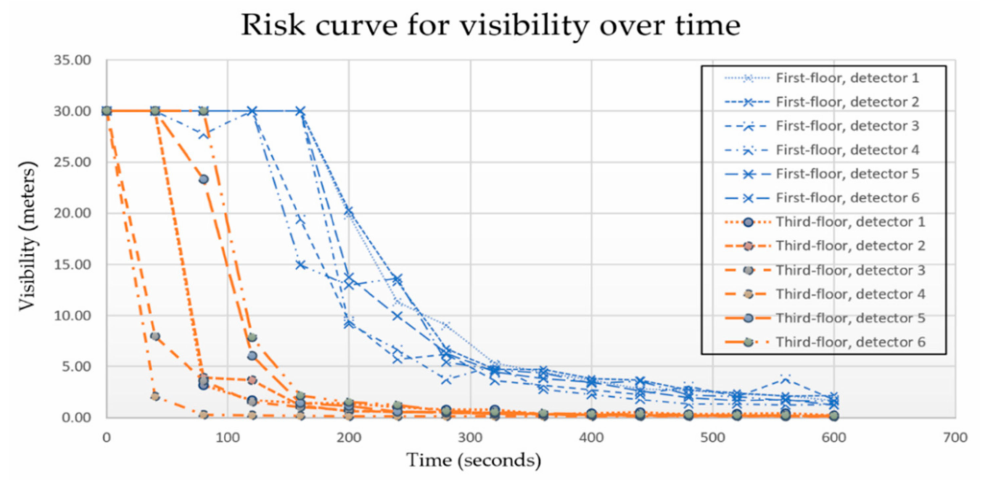
Figure 4. Risk curve for visibility data over time.